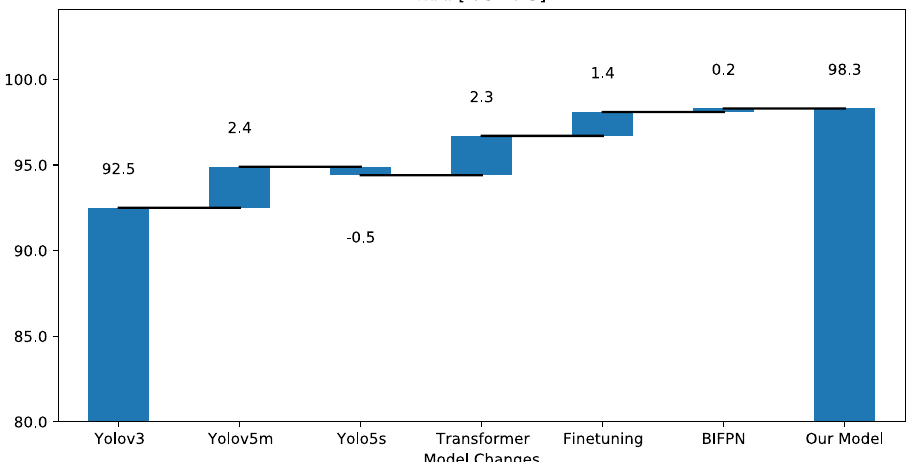
Figure 7. Mean average precision (mAP) waterfall chart showing that we find a significant improvement when we change in the model architecture. The maximum improvement can be attributed to the transformer module. Our model in the chart refers to the proposed model with BIFPN neck.